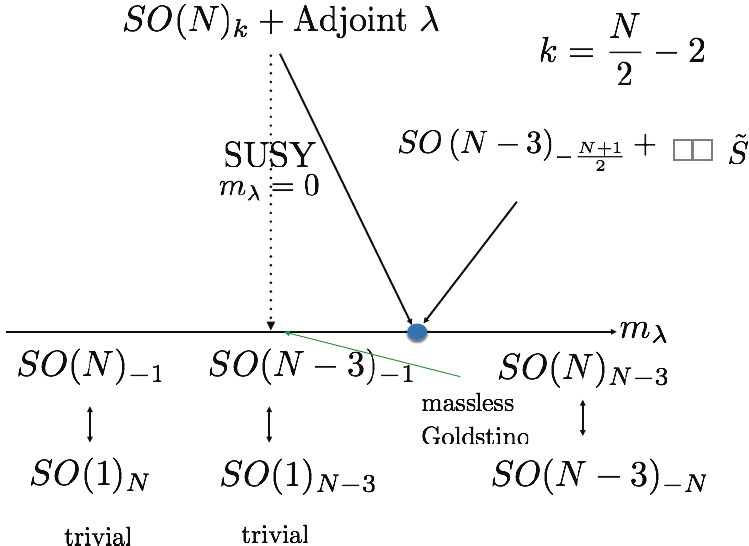
Figure 13: The phase diagram of SO ( N ) gauge theory with an adjoint fermion and k − 2. There is one transition that connects a nontrivial Chern-Simons level k = N 2 TQFT and a trivial one. In addition at one point the Goldstino becomes massless. We propose a fermionic dual for the nontrivial transition.